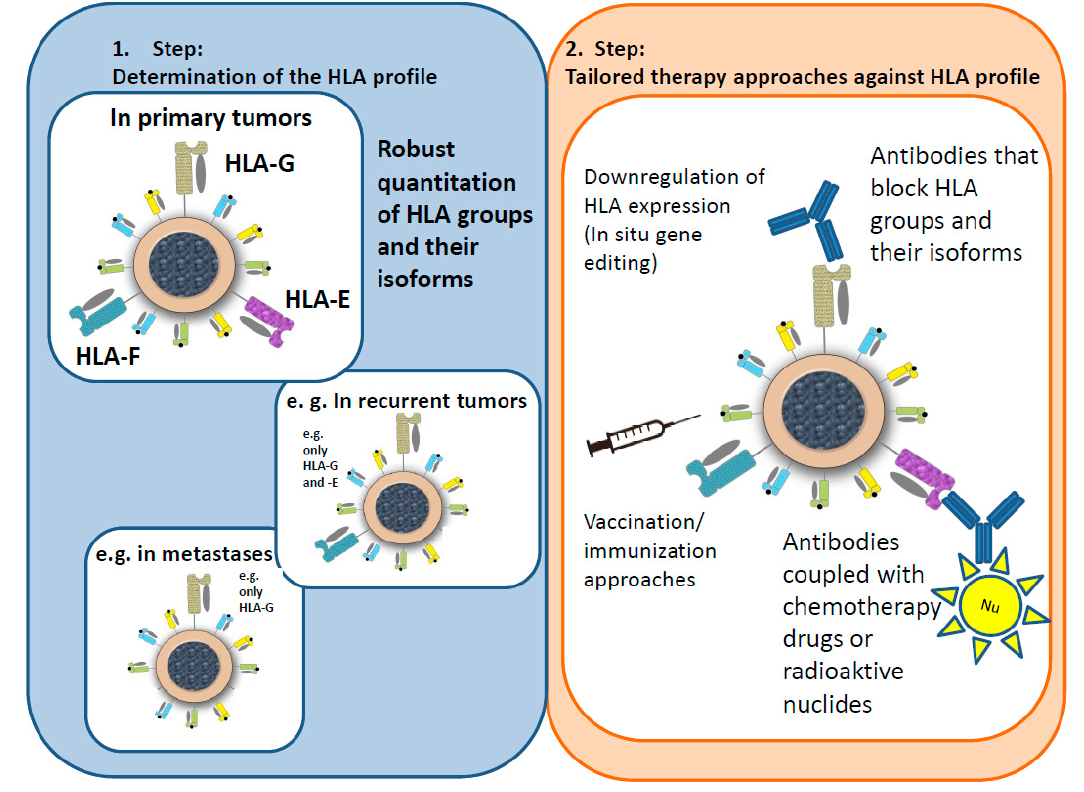
Figure 4. Hypotheses for an immunological tumor therapy concept (ITTC). The patent focuses on determining the individual expression pattern of the “embryonic” HLA genes on primary tumors to create individual therapy approaches such as antibodies drug conjugates, vaccination/immunization approaches and in situ gene editing to block and downregulate HLA class Ib expression in order to overcome immune evasion mediated by the non-classical HLA groups. The patent also implies the monitoring of the HLA expression patterns on recurrent tumors and metastases for subsequent treatment adaptations.